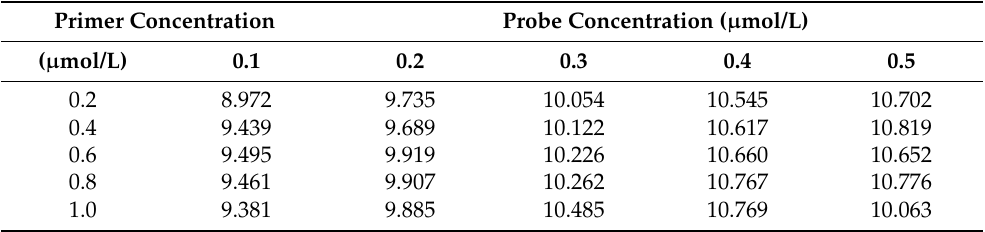
Table 1. The Cq value of BrYV in the TaqMan RT-qPCR assay using different primer and probe